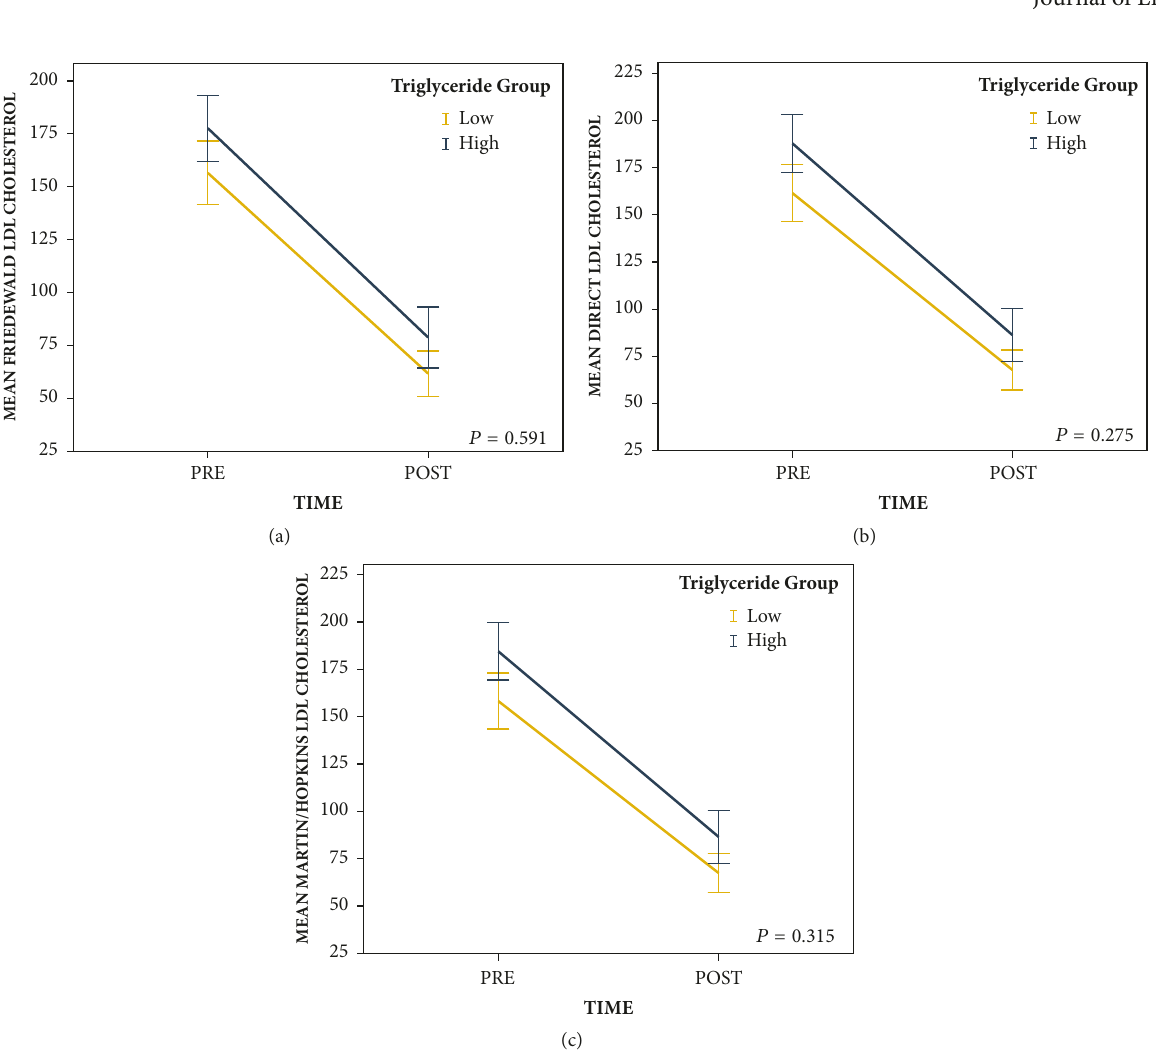
receptors and must rely on HSPG-R for remnant